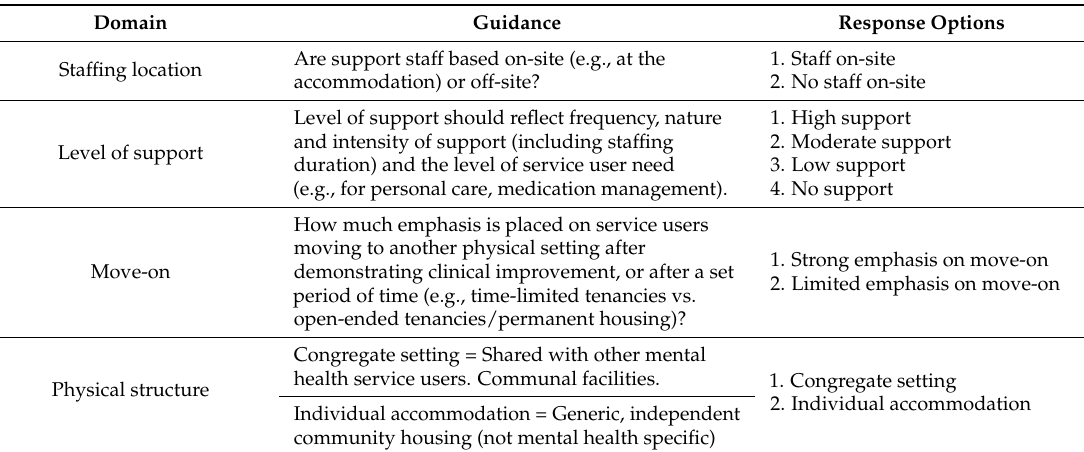
Table 5. Domains and response guidance for the STAX-SA.